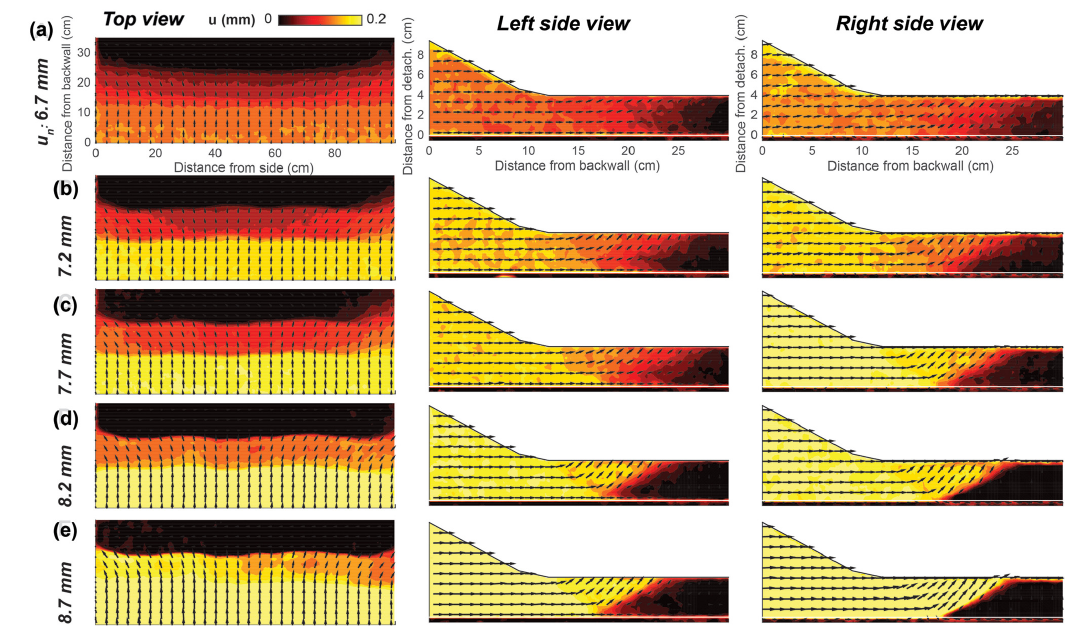
Figure 2. Incremental displacement fields of top and side views of experiment E374 (glass detachment and moving base) throughout the development of the first thrust pair at 0.5mm increments of applied backwall displacement, u n . (a) Preceding thrust fault development, the net displacement gradually decreases from the backwall toward the opposite wall. (b) When sharp gradients in the top view displacement field revealed the development of the first thrust pair within the center of the box, the side view displacement fields showed more diffuse zones of shear. (c–e) With continued backwall displacement, the gradients in the top and side view displacement fields progressively sharpened as faults localized. The top view displacement fields reveal that the thrusts began to localize within the center of the sand pack and then extended toward the sidewalls. The side view displacement fields indicate that fault localization began earlier on the right side than the left side in this experiment (c) . The forethrust remained more diffuse on the left side view than the right side view in the last increment shown here (e)